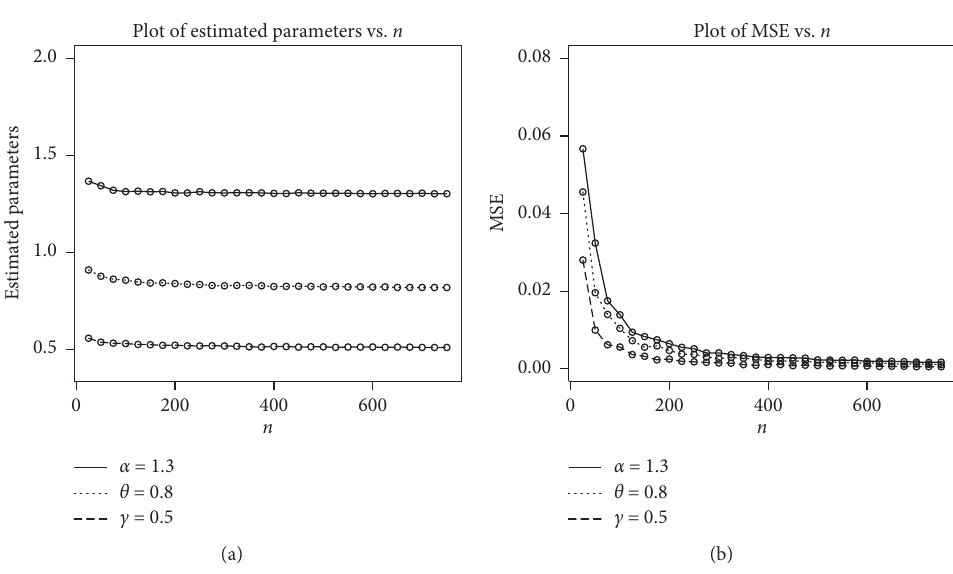
Figure 5: MLEs and MSEs plots of the NGE-Weibull distribution for α � 1 . 3, θ � 0 . 8, and c � 0 . 5. Plot of absolute bias vs. n